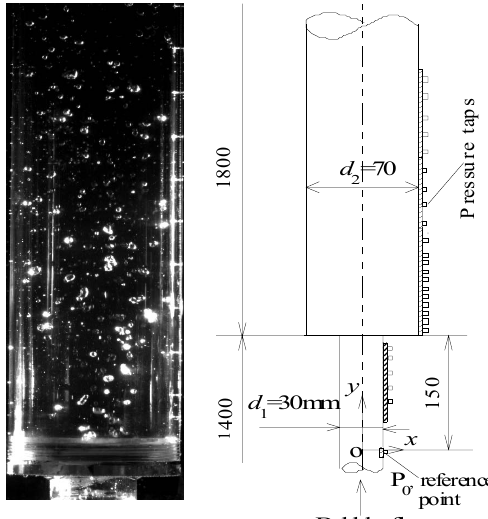
Fig.1 Test Section, normal expansion